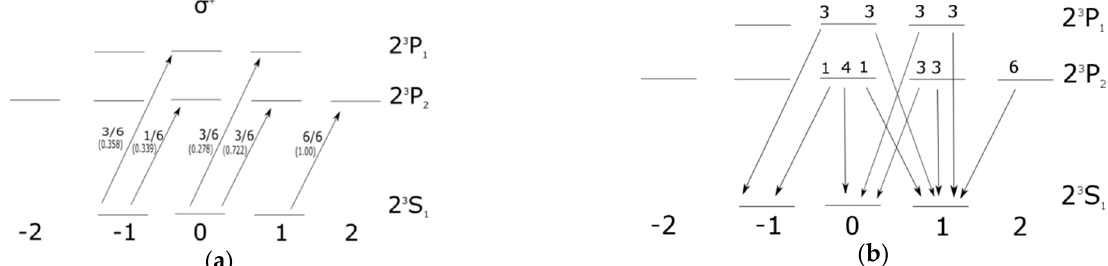
arcs): ( a ) excitation, values in parentheses for 810 G; ( b ) relaxation.